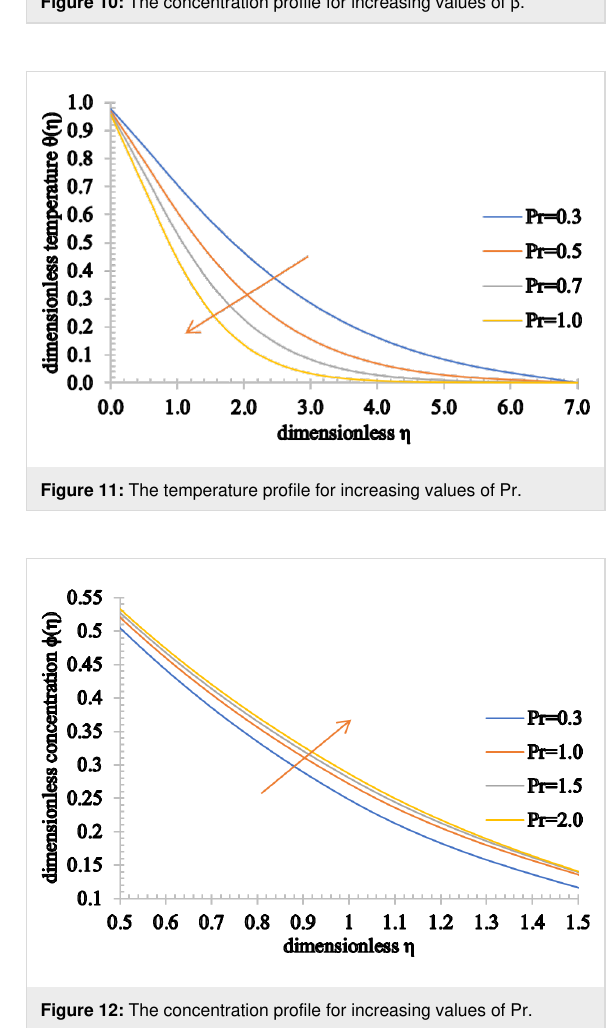
between the kinetic energy of the fluid particles and the bound- ary layer enthalpy. The kinetic energy of the fluid particles in- creases for higher values of Ec . Hence, the temperature of the fluid rises marginally and therefore, the associated momentum and thermal boundary layer thickness are enhanced.